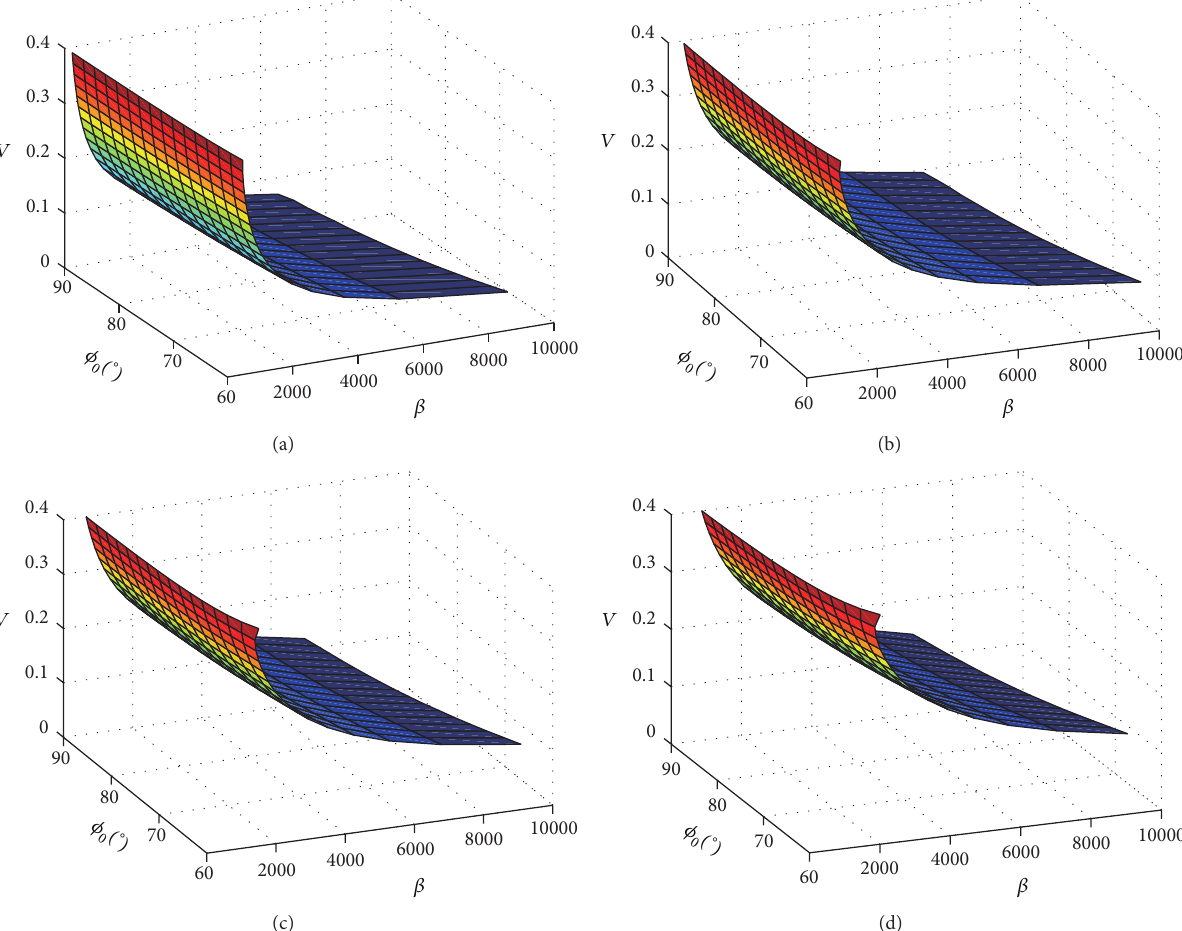
Figure 4: Dropping damage boundary surfaces of the system when the product fragility (a) 𝐴 𝑐 = 5 , (b) 𝐴 𝑐 = 10 , (c) 𝐴 𝑐 = 15 , and (d) 𝐴 𝑐 = 20 . 𝑉 : the dimensionless dropping shock velocity; 𝛽 : the system parameter; 𝜙 0 : the suspension